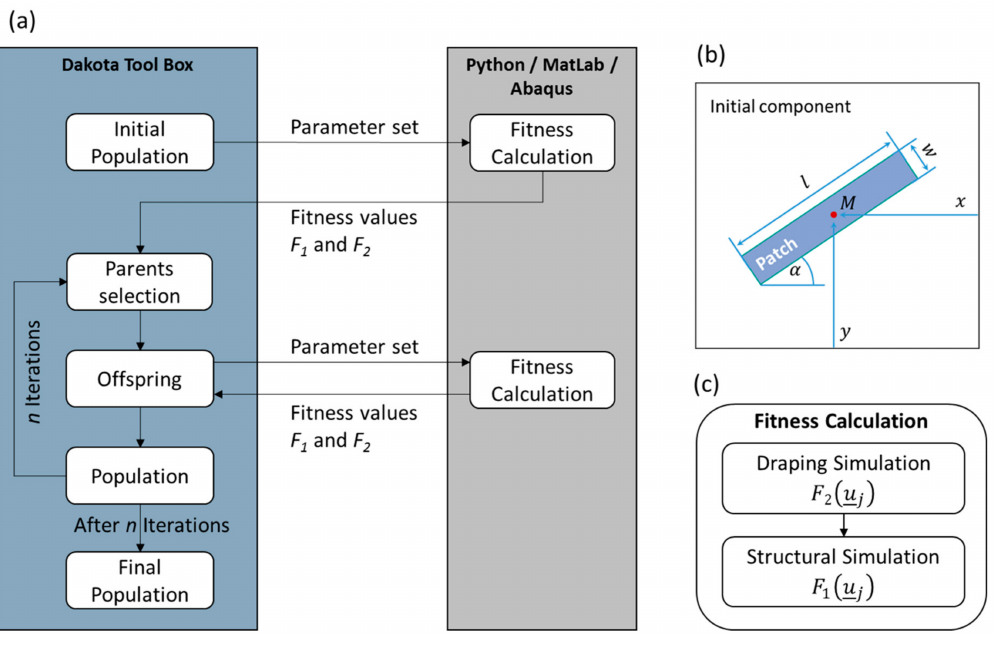
Figure 7. Integration of the fitness calculation in the genetic optimization algorithm of the Dakota tool box ( a ), used to solve the patch optimization problem ( b ) by applying the two-step fitness calculation ( c